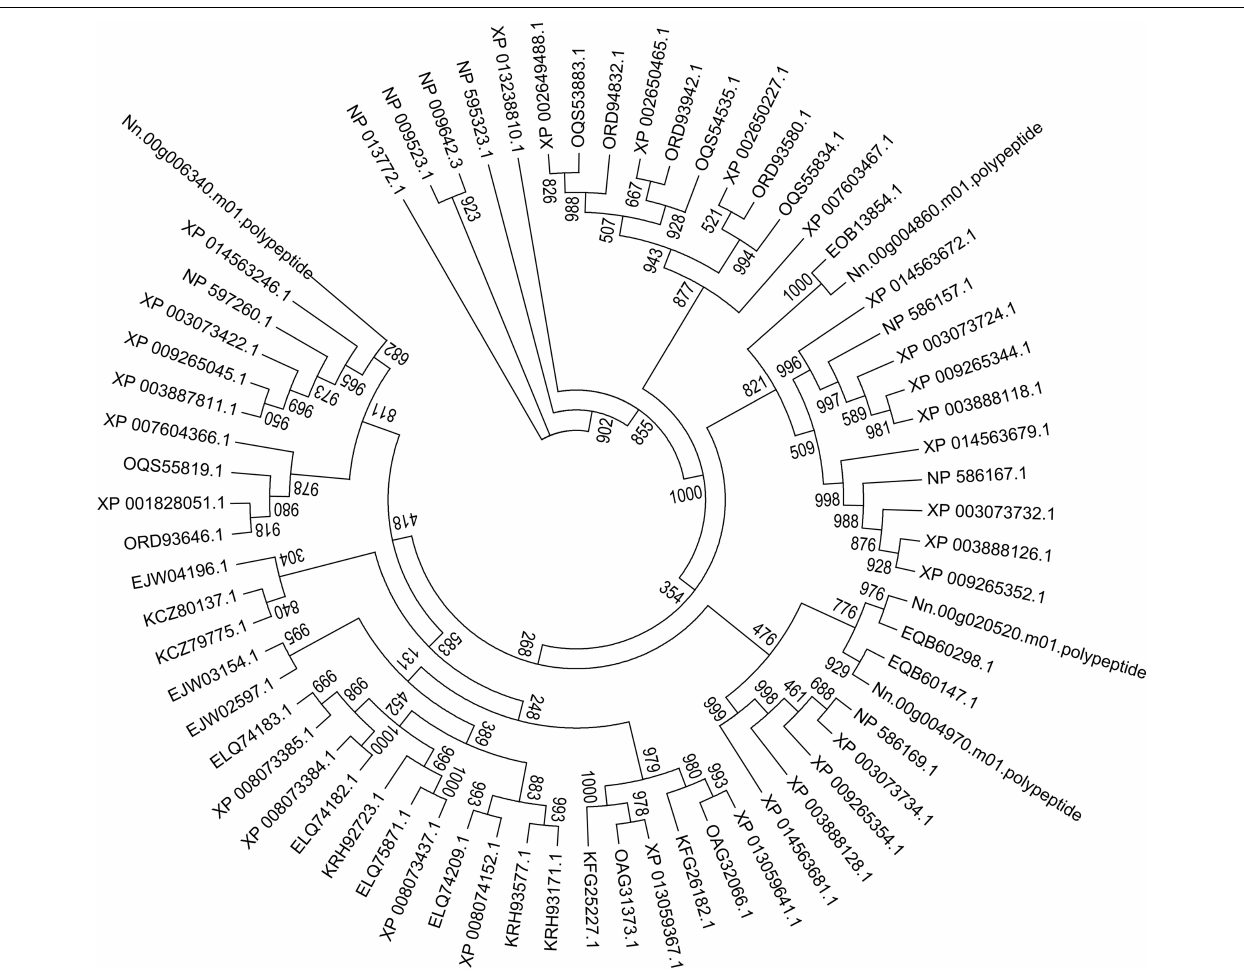
FIGURE 9 | Maximum-likelihood phylogenetic tree generated based on ATP/ADP carrier proteins in 23 fungal genomes. Based on the total aligned 68 ATP/ADP carrier proteins, the tree, rooted with ATP/ADP carrier in S. cerevisiae and S. pombe , was calculated with PhyML based on JTT mode with 1,000 replications. Bootstrap values are indicated at the base of each